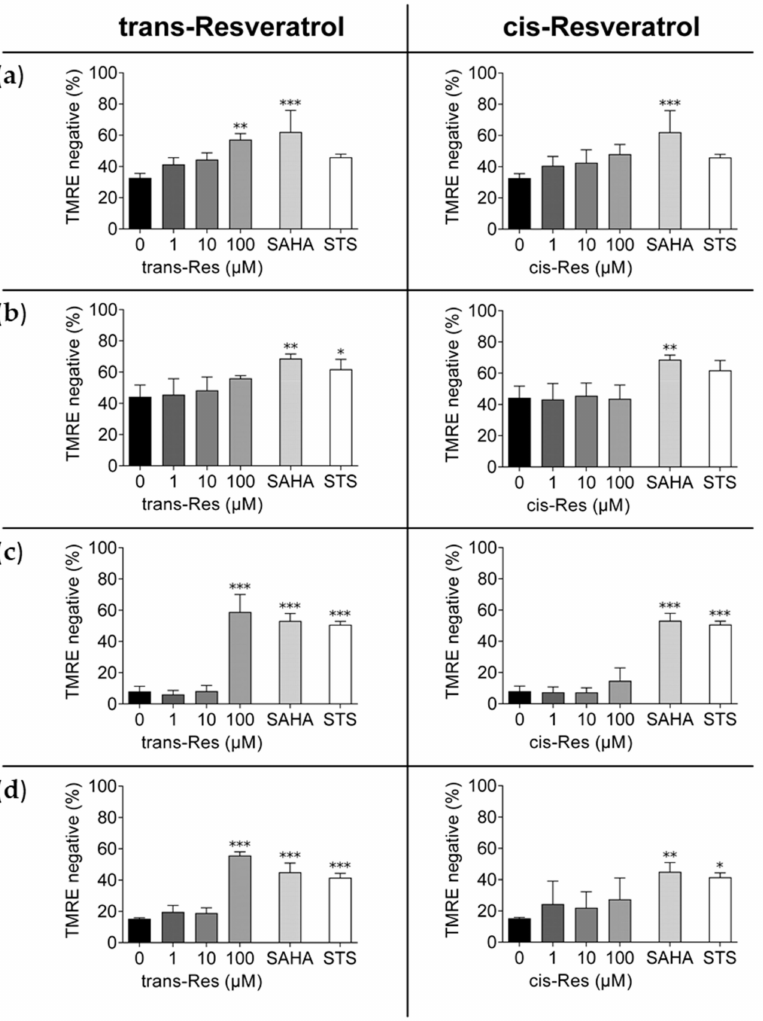
Figure 5. Reduced TMRE staining of mitochondria in hepatoma and colon carcinoma cells by trans- versus cis-resveratrol, evaluated by flow cytometry. ( a ) HepG2, ( b ) Hep3B (hepatoma), ( c ) HCT-116, and ( d ) HCT-116/p53 ( − / − ) (colon carcinoma) cells were exposed to different concentrations of trans- and cis-resveratrol (1 µ M, 10 µ M, 100 µ M) for 72 h; 10 µ M SAHA was applied as positive control and 5 µ M STS as control for apoptotic cell death. Experiments were replicated in three independent experiments. Error bars represent mean ± SD, statistical analysis with the Dunnet’s multiple compar- ison test, confidence interval 95%. *: p ≤ 0.05; **: p ≤ 0.01; ***: p ≤ 0.001. Res, resveratrol; SAHA, suberoylanilide hydroxamic acid; STS, staurosporine; TMRE, tetramethylrhodamine ethyl